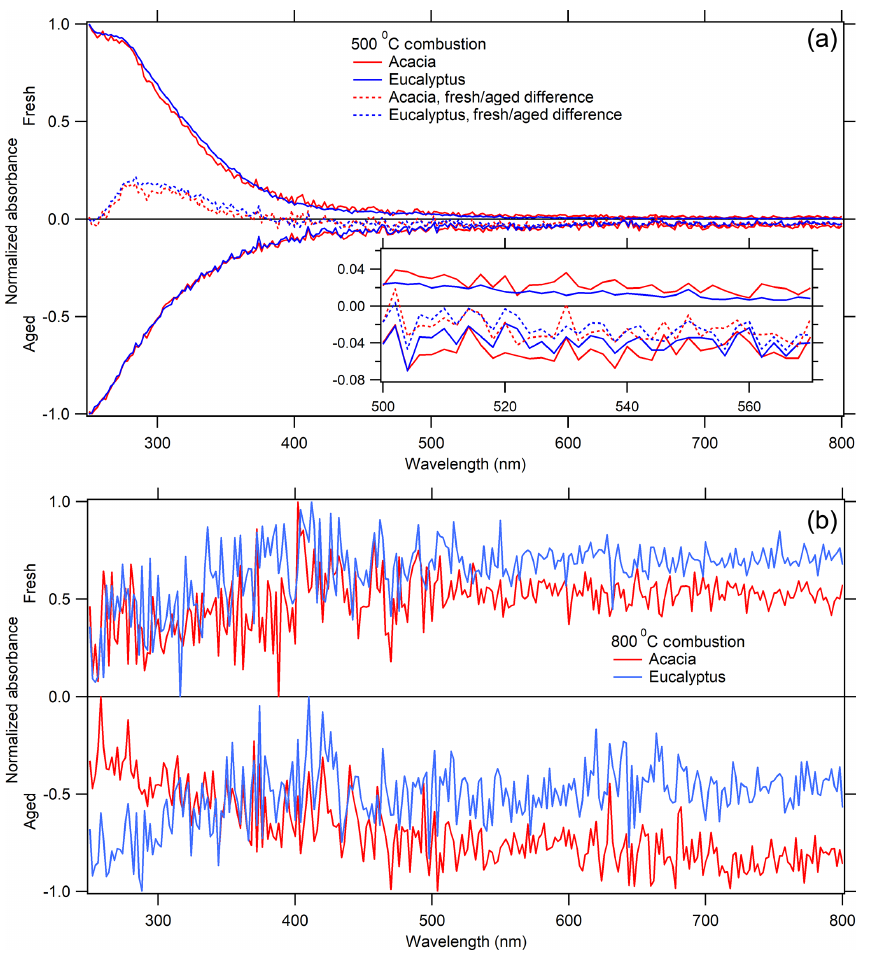
Figure 5. The UV–visible spectrum for each fuel combusted at 500 ◦ C (a) and 800 ◦ C (b) , showing the result from fresh combustion with positive values and photochemically aged with negative values. These spectra have been averaged over the entire chromatogram, background- subtracted, and normalized, as described in Sect. 2.6. The differences between them are highlighted with the dashed line, and an enlargement of the 500–570nm region is presented in the